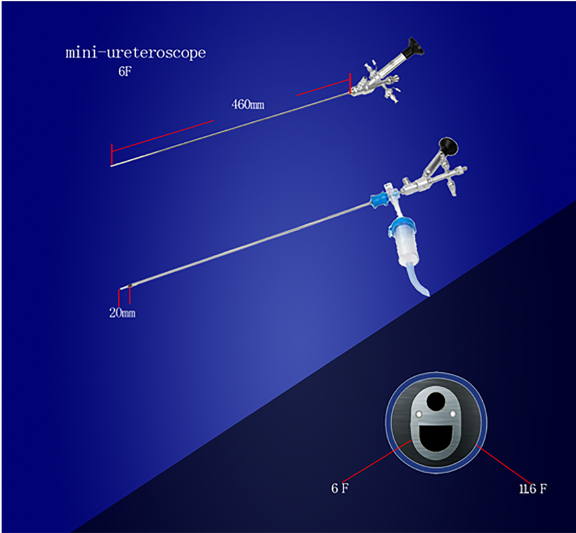
Figure 2 - Mini-ureteroscope.